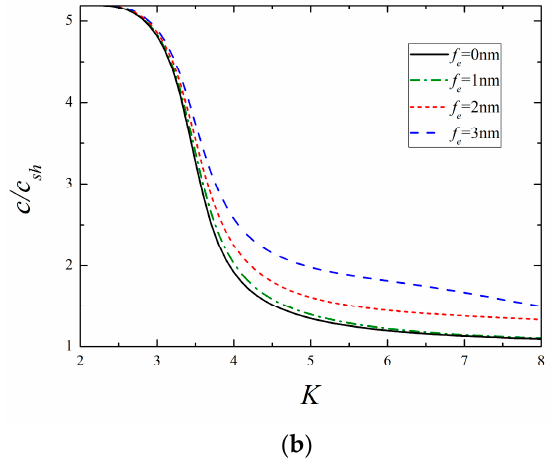
Figure 5. The lowest two modes for different surface piezoelectricity ( f c = 0.5 nm, f κ = f ρ = 1 nm). ( a ) The 1st mode and ( b ) the 2nd mode.